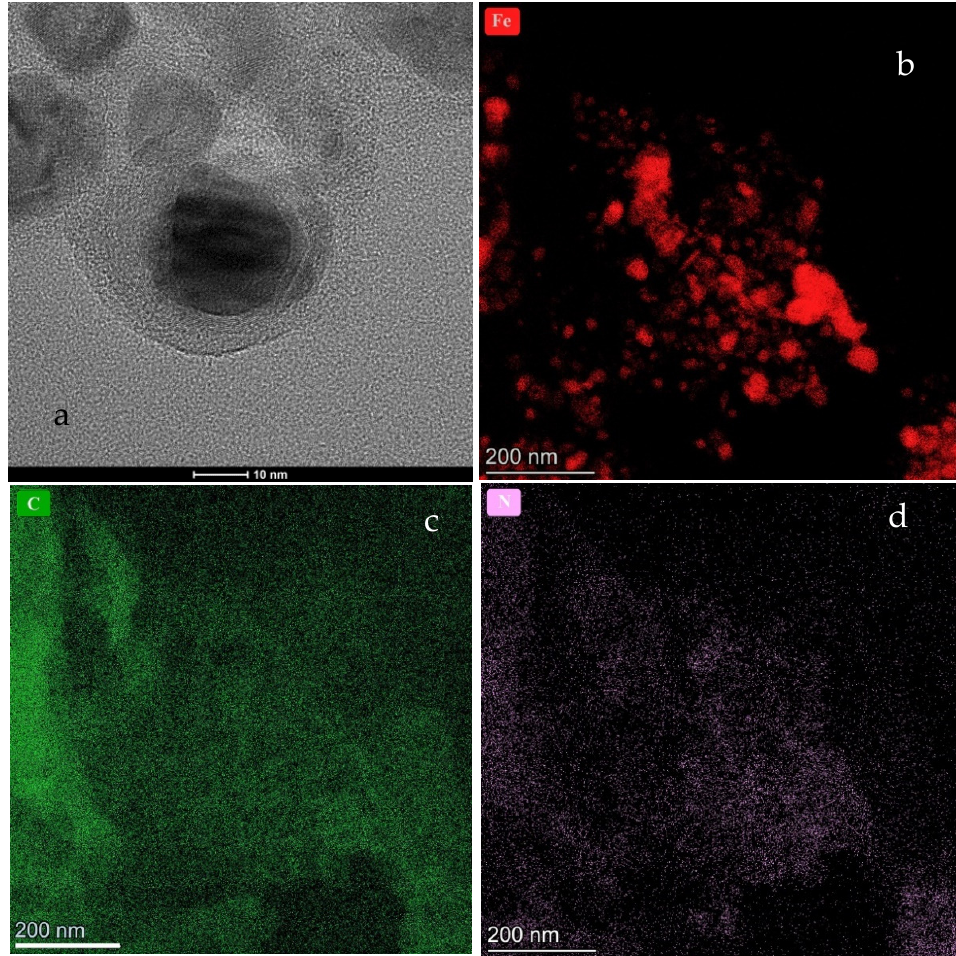
Figure 3. HR-TEM images of the ( a ) CFeN@rGO-COOH sample. Additionally, elementals mapping analysis of ( b ) Fe, ( c ) C, and ( d ) N are displayed.